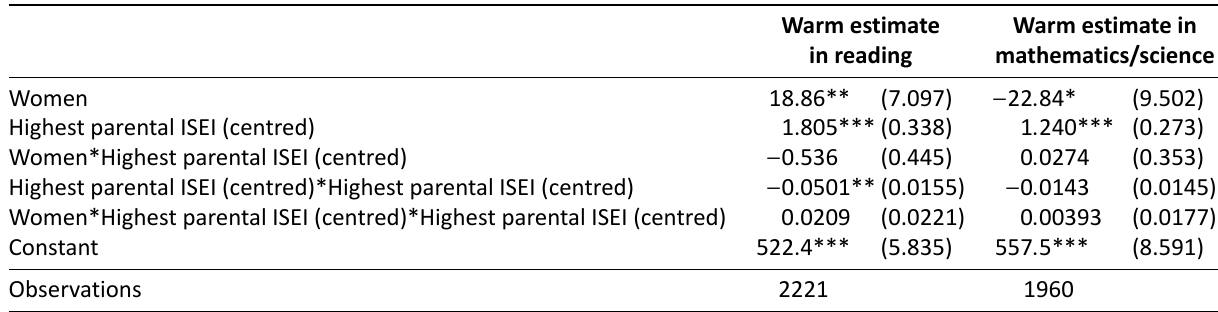
Figure 1. Predictions of reading and mathematics/science skills by parental social status (ISEI) and gender, grey lines: 95%-CI. Table 2. Effects on reading and mathematics/science skills (OLS coefficients). Source: PISA (2000) and TREE waves 1–9 (weighted; 2016).